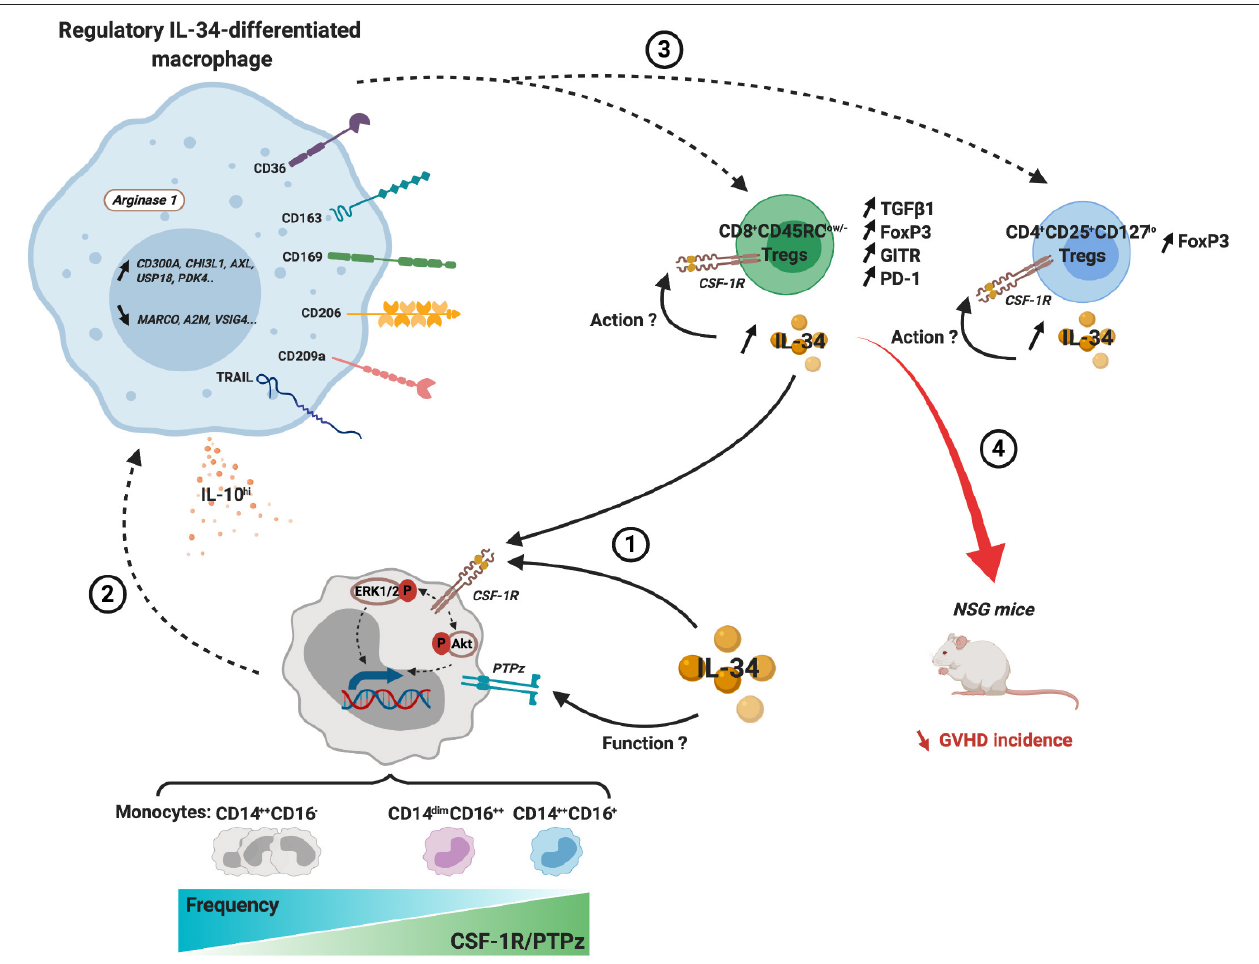
FIGURE 7 | Integrated scheme of the regulatory actions of IL-34-differentiated macrophages and their ability to potentiate FOXP3 + Tregs. (1) IL-34 exogenously administered or from endogenous sources, such as from Treg, acts through CSF-1R to preferentially differentiate classical and intermediate monocytes into regulatory macrophages (2). (3) IL-34-differentiated macrophages expand and enhance the suppressive phenotype of both CD4 + CD25 + CD127 low and CD8 + CD45RC low / − Tregs. IL-34 secretion by Tregs maintains and increases the regulatory loop and can act in an autocrine fashion on Tregs. (4) In GVHD in NSG mouse, expanded CD8 + Tregs efficiently delay GVHD incidence. Dashed arrow, induction; solid arrow,